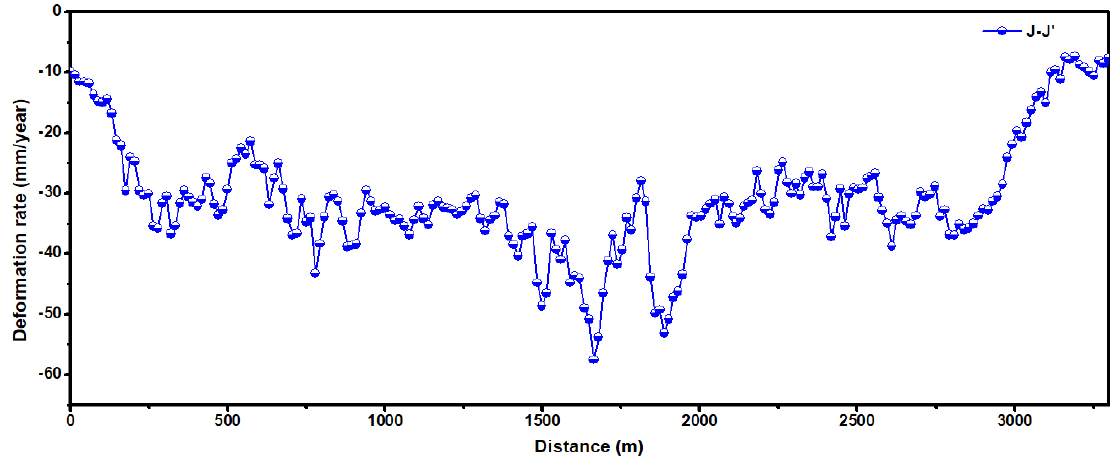
Figure 13. Average deformation rate in the vertical direction of Region G from January 2017 and October 2018 along Profile J–J’, whose position are indicated as solid black lines in Figure 12.